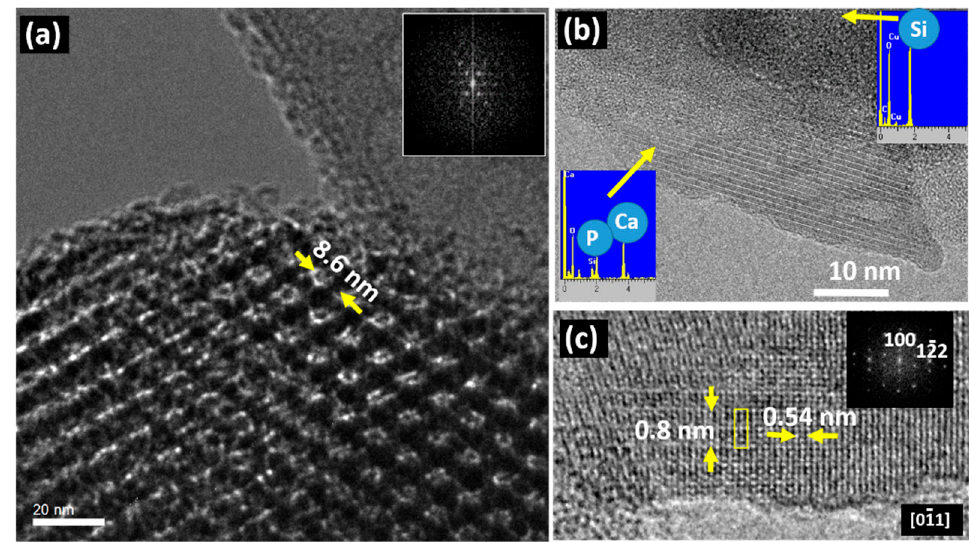
Figure 4. ( a ) TEM image of SBA-15 before immersion for 60 days in SBF. The corresponding Fast Fourier Transform (FFT) is shown in the inset; ( b ) TEM image of an acicular particle formed after 60 days in SBF. EDS spectra performed on the particle and the amorphous matrix are shown as insets; ( c ) HRTEM detail of an acicular particle and its FFT. Adapted with permission from [45]. Copyright Elsevier (Amsterdam, The Netherlands).